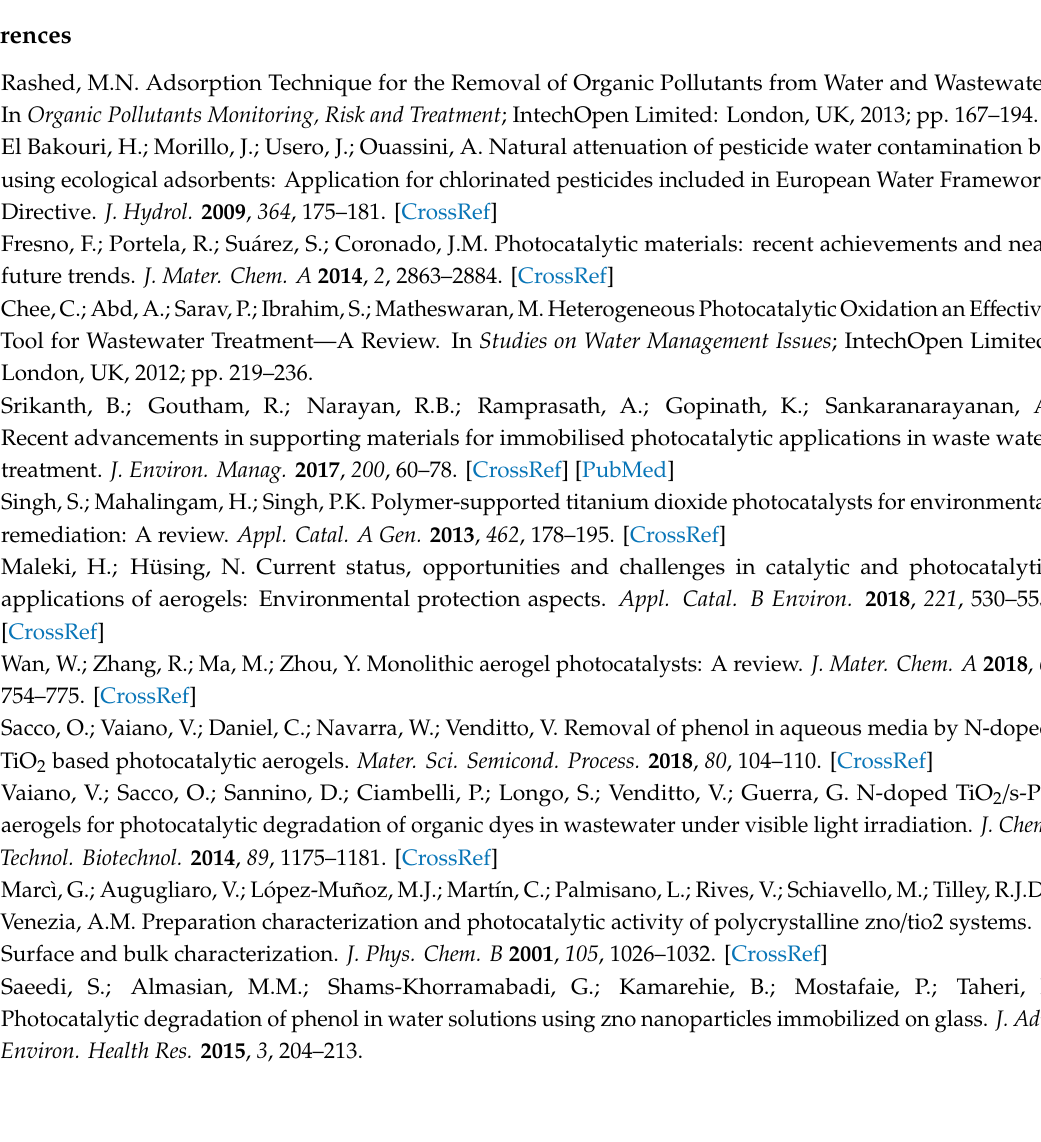
Figure S1: The X-ray di ff raction patterns of ZnO / s-PS aerogels with ZnO loading up to 15